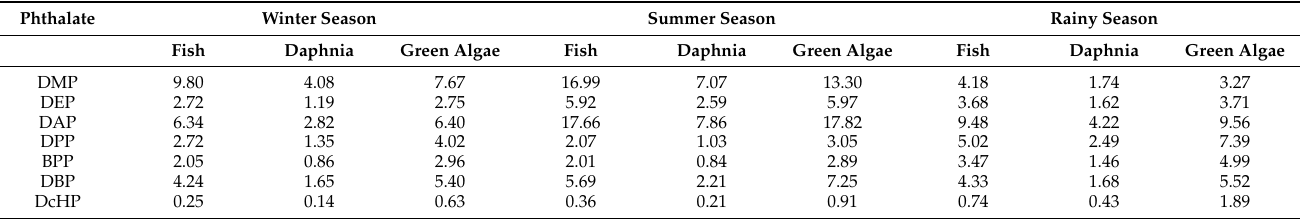
Table 5. Sediment risk assessment of phthalate esters in water for fish; daphnia and green